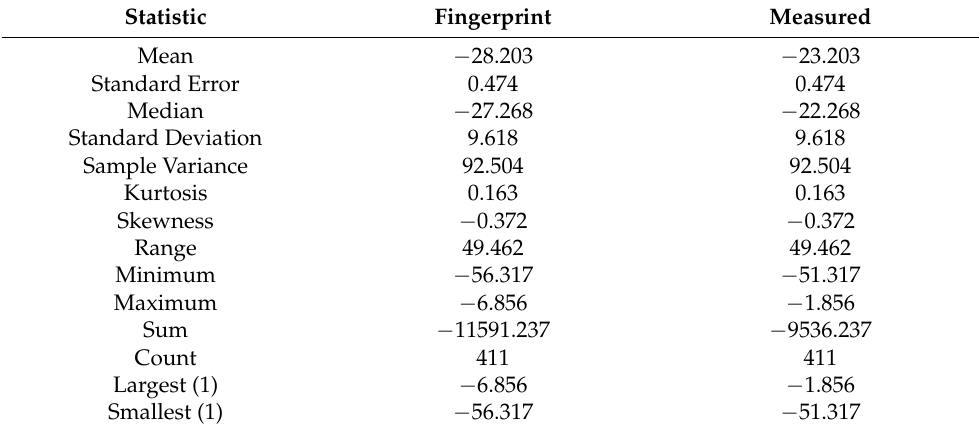
Table 11. Sub-region 3: Descriptive statistics comparison between fingerprint and measured FRA profiles.